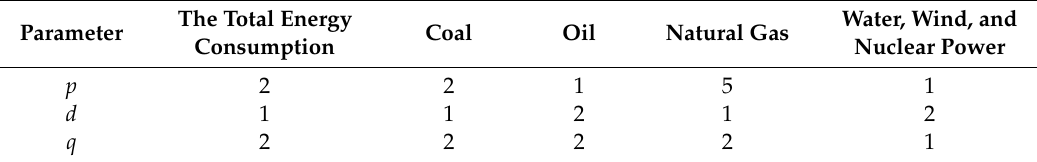
Table 8. Weight distribution of ARIMA-SVR.